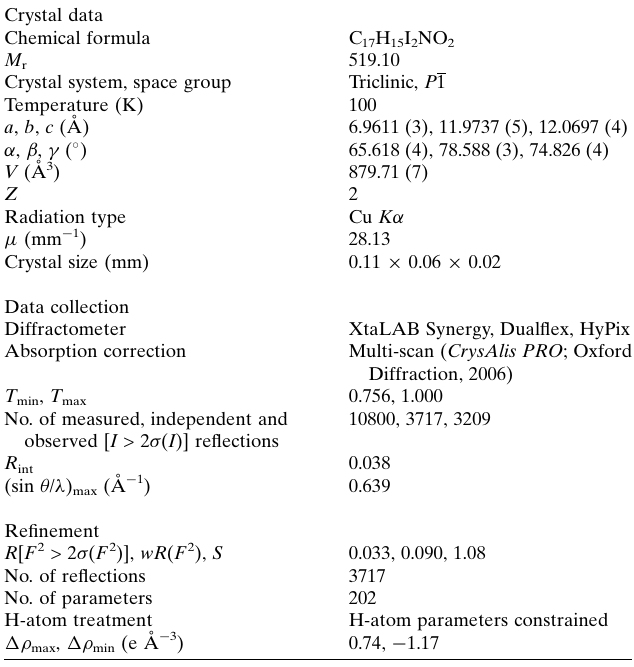
Table 1 Experimental details. Crystal data Chemical formula